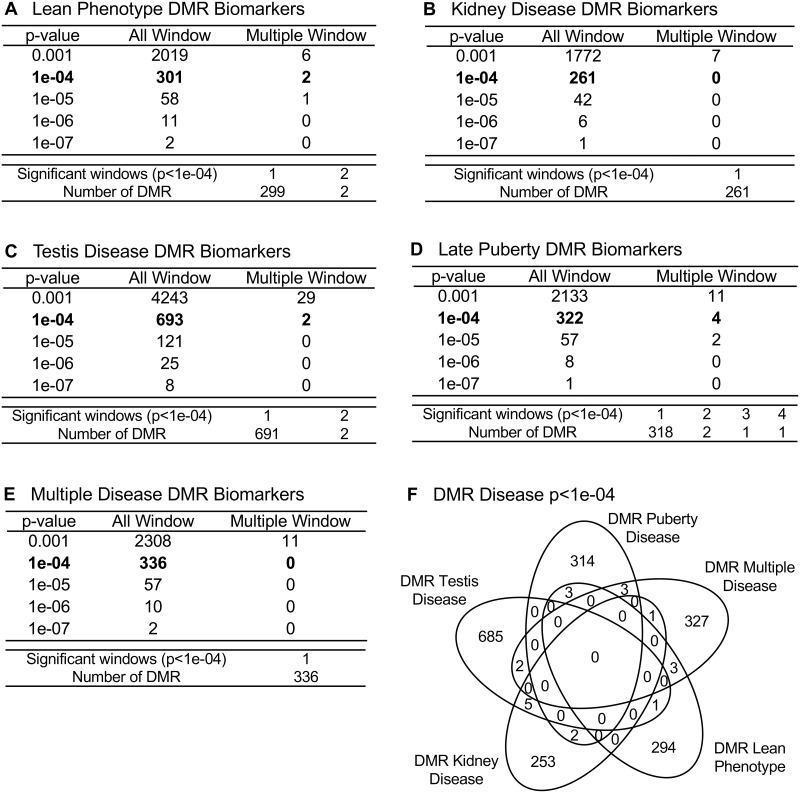
DMR identification and numbers.The number of DMRs found using different p-value cutoff thresholds. The All Window column shows all DMRs. The Multiple Window column shows the number of DMRs containing at least two nearby significant windows (1 kb each). The number of DMRs with the number of significant windows (1 kb per window) at a p-value threshold of p<1e-04 for DMR is bolded. (A) Lean phenotype DMRs; (B) Kidney disease DMRs; (C) Testis disease DMRs; (D) Late puberty DMRs; and (E) Multiple disease DMRs. (F) Venn diagram overlap disease specific DMR at p<1e-04.